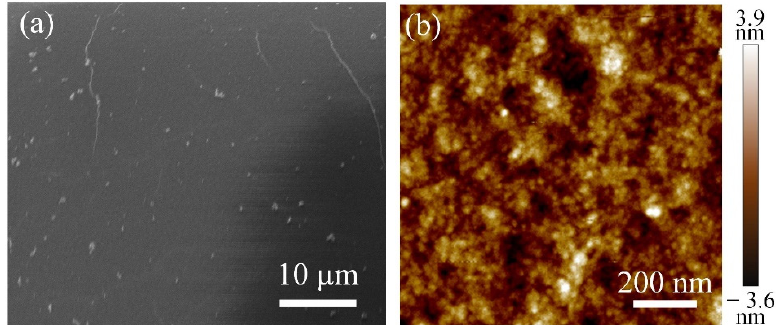
Figure 2. ( a ) SEM and ( b ) AFM image of as-grown PPy film.